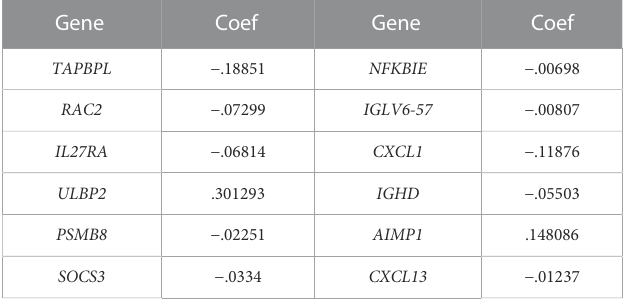
TABLE 1 LASSO coef fi cient pro fi les of 12 prognostic immune-related genes. Gene Coef Gene Coef